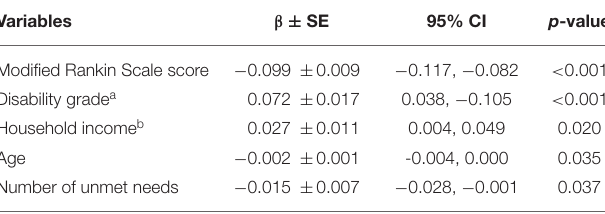
TABLE 2 | Final multiple linear regression model for health-related quality of